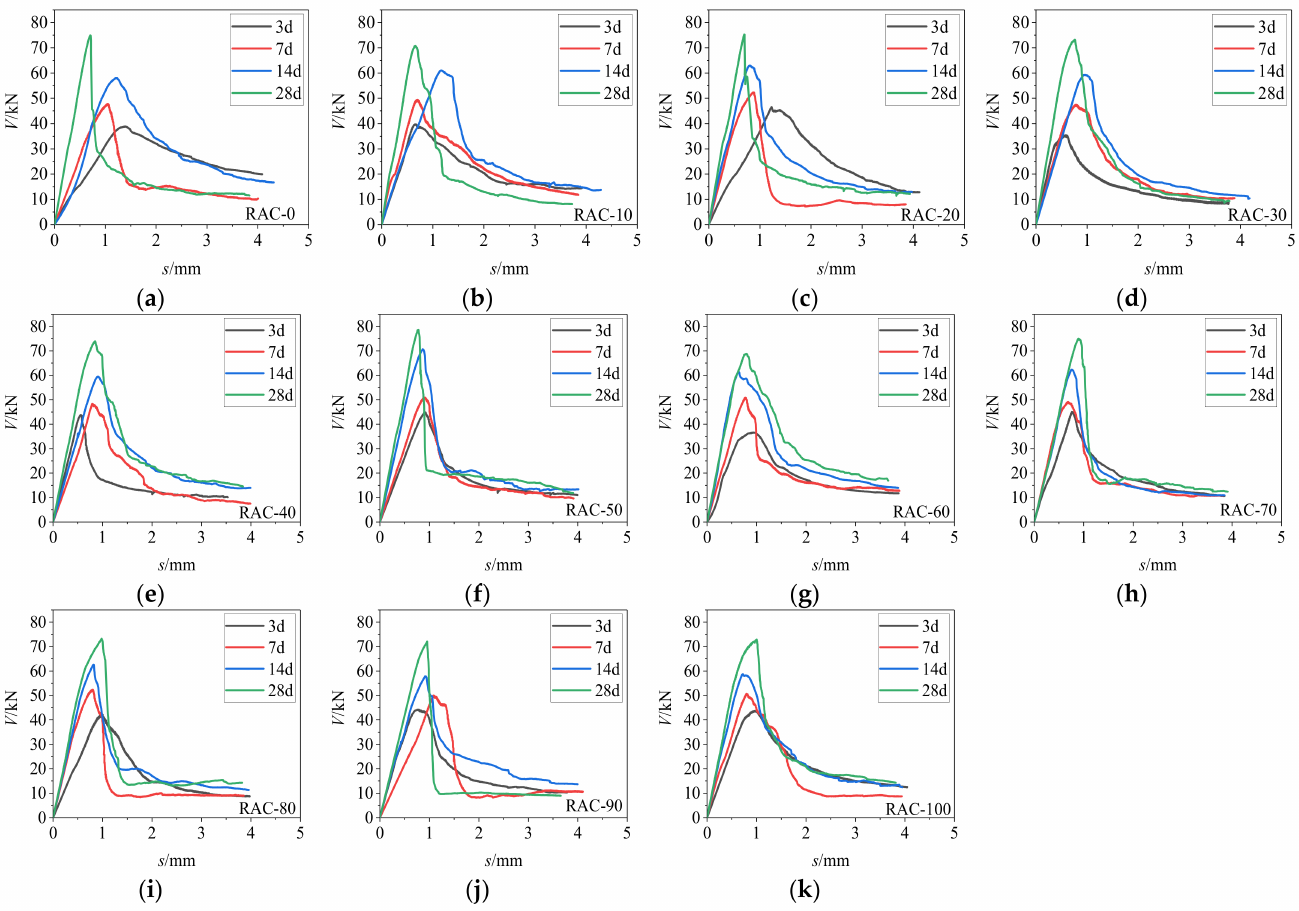
Figure 5. Load–displacement curves of specimens: ( a ) RAC-0. ( b ) RAC-10. ( c ) RAC-20. ( d ) RAC-30. ( e ) RAC-40. ( f ) RAC-50. ( g )